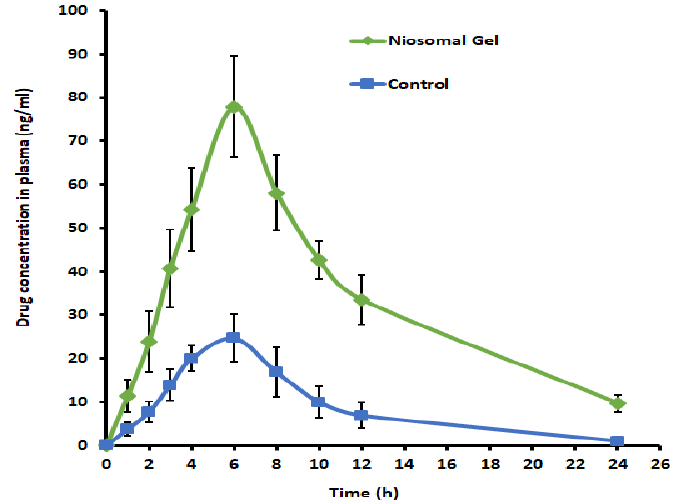
Figure 12. Plasma drug concentrations–time profiles of levosulpiride from niosomal gel and control gel in rats. Each value depicts the average and standard deviation of six different batches. Table 3. Estimated pharmacokinetic parameters of levosulpiride in plasma after transdermal ad- ministration in Wistar rats. Each value depicts the average and standard deviation of six di ff erent batches.